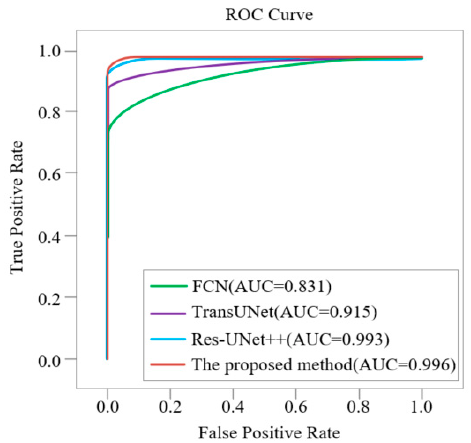
Figure 6. Comparison of ROC curves of different models on the test dataset of macular edema OCT images.